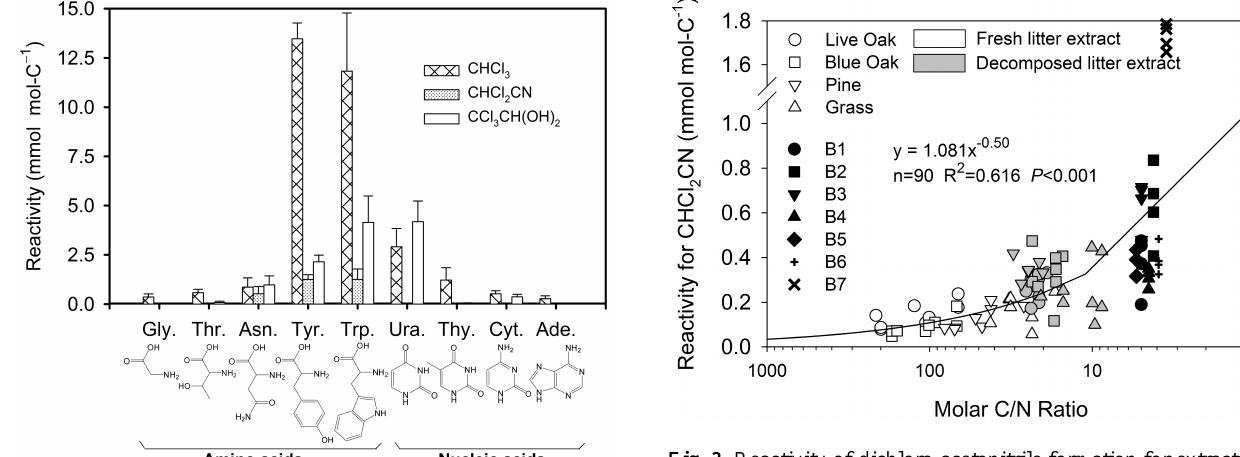
Fig. 3. Reactivity of dichloro-acetonitrile formation for extracts of fresh litter ( n = 32), decomposed litter ( n = 30) and bacterial sus- pensions ( n = 28) along a C / N ratio gradient. B1–B7 refer to the same seven different bacterial strains in Fig.